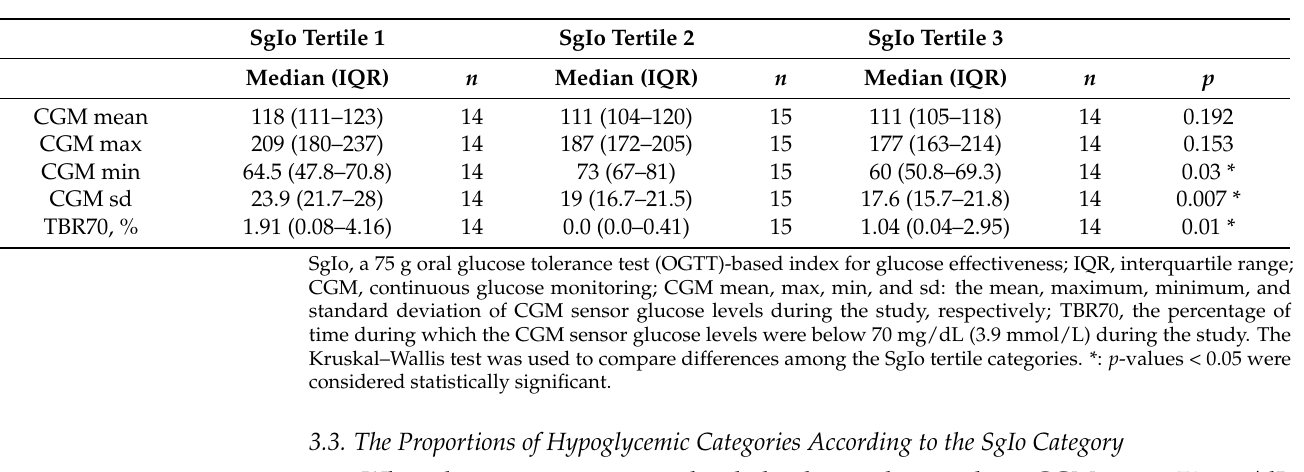
Table 2. The CGM indices according to the SgIo tertile category.